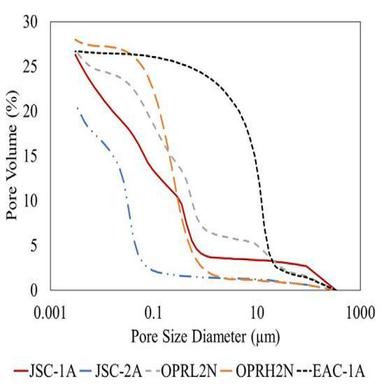
MIP curves for the 28-day geopolymer lunar concrete samples.